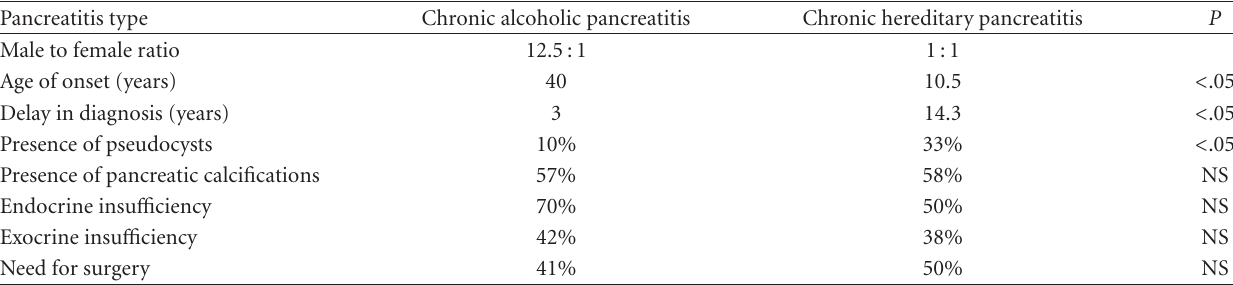
Table 3: Comparison of chronic alcoholic and chronic hereditary